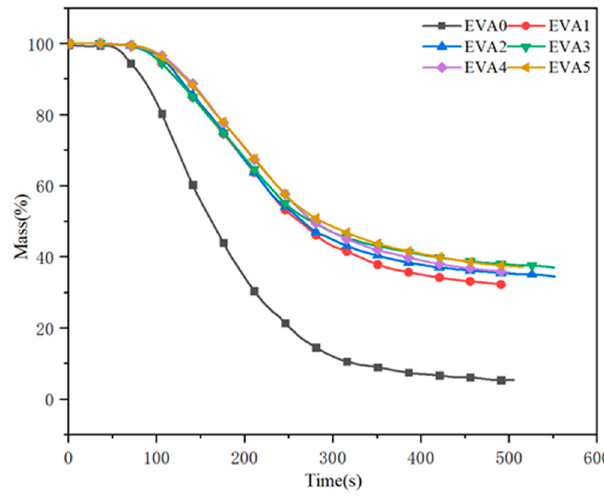
Figure 11. Mass curves of neat EVA and EVA/MH composites.